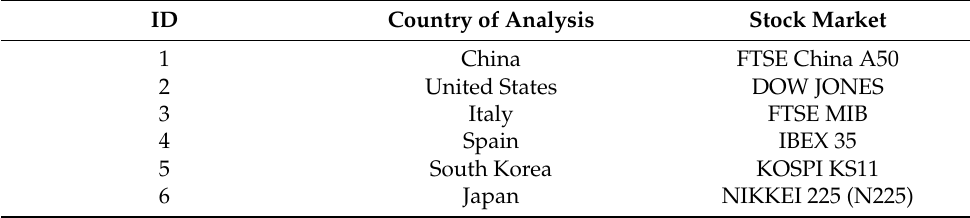
Table 4. Selected stock